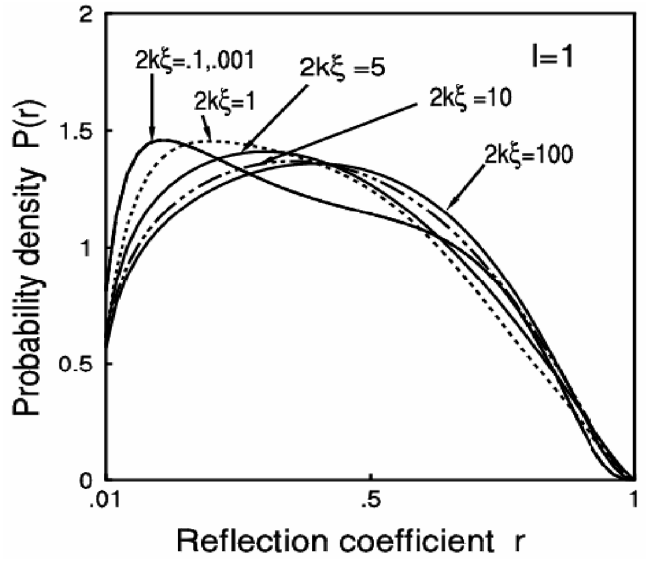
Figure 8. Reflection coefficient r distribution P(r) against the disorder parameter 2 k ξ for a fixed sample length l =